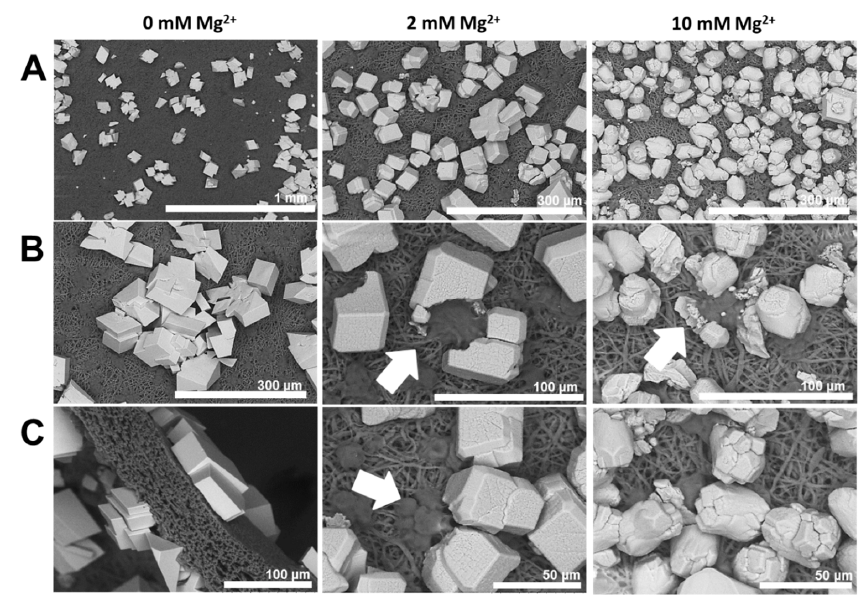
Figure 4. Representative SEM images of outer membrane surfaces mineralized in the presence of different Mg 2+ contents. Arrows indicate mammillae-associated crystals.